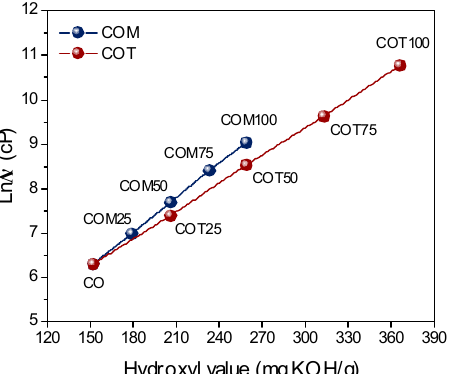
Figure 2. Viscosity as a function of hydroxyl value of the polyol blends at room